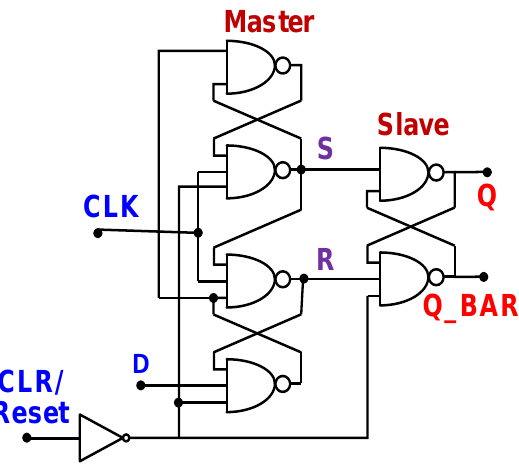
Figure 15. Adopted DFF with asynchronous reset circuit design.